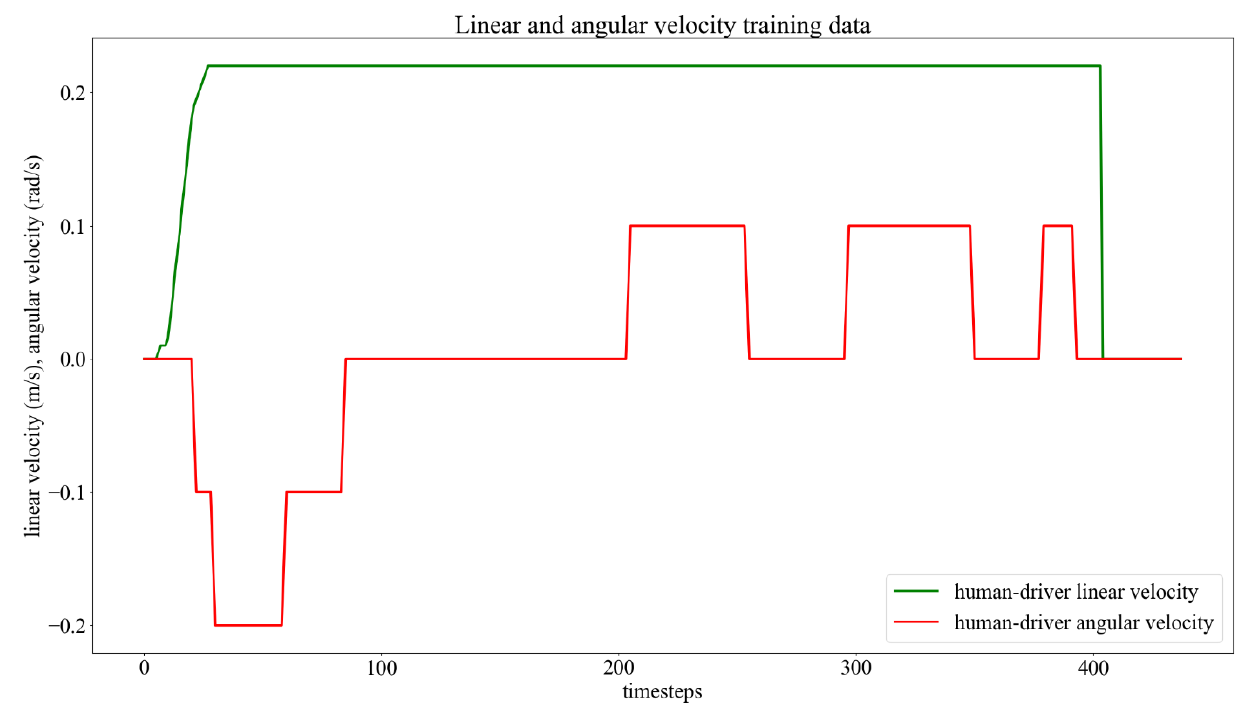
Figure 9. Velocity commands for one trajectory given by the user for training.